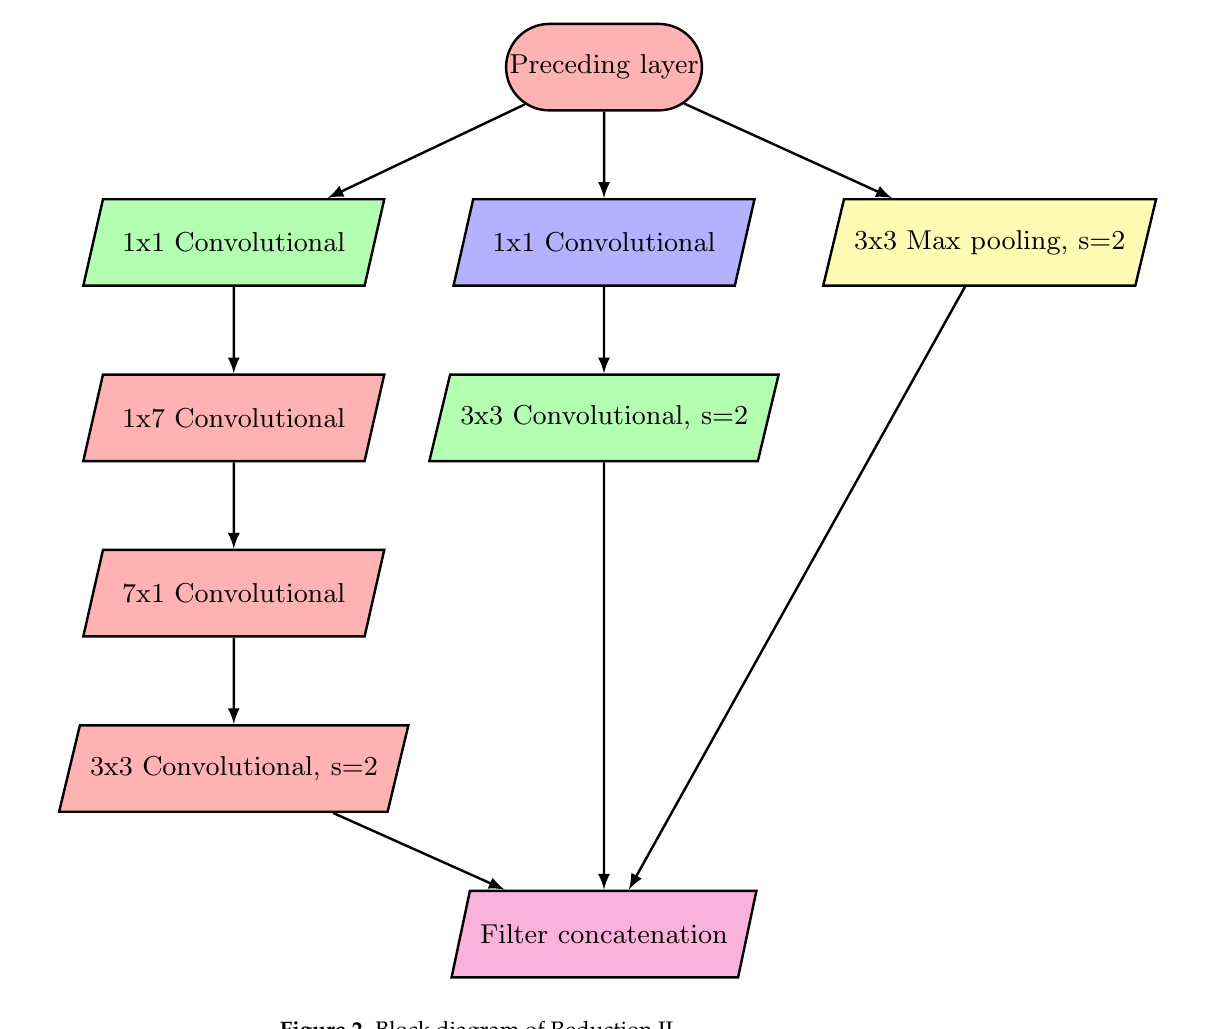
Figure 2. Block diagram of Reduction